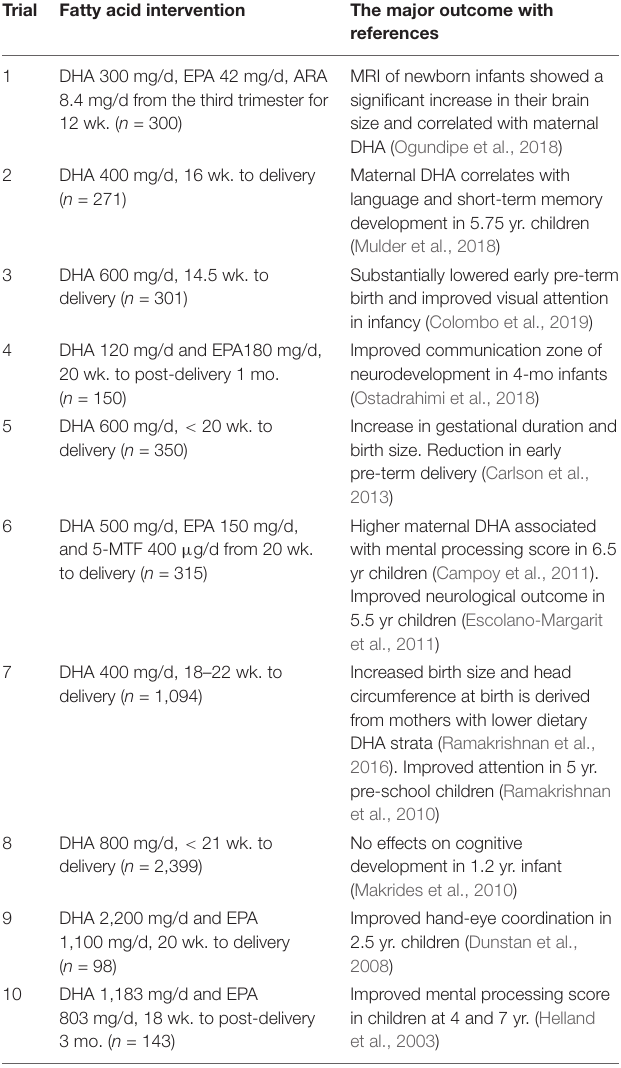
TABLE 2 | Effects of maternal long-chain polyunsaturated fatty acids during pregnancy on brain development and growth in infant and children: clinical trials. Trial Fatty acid intervention The major outcome with